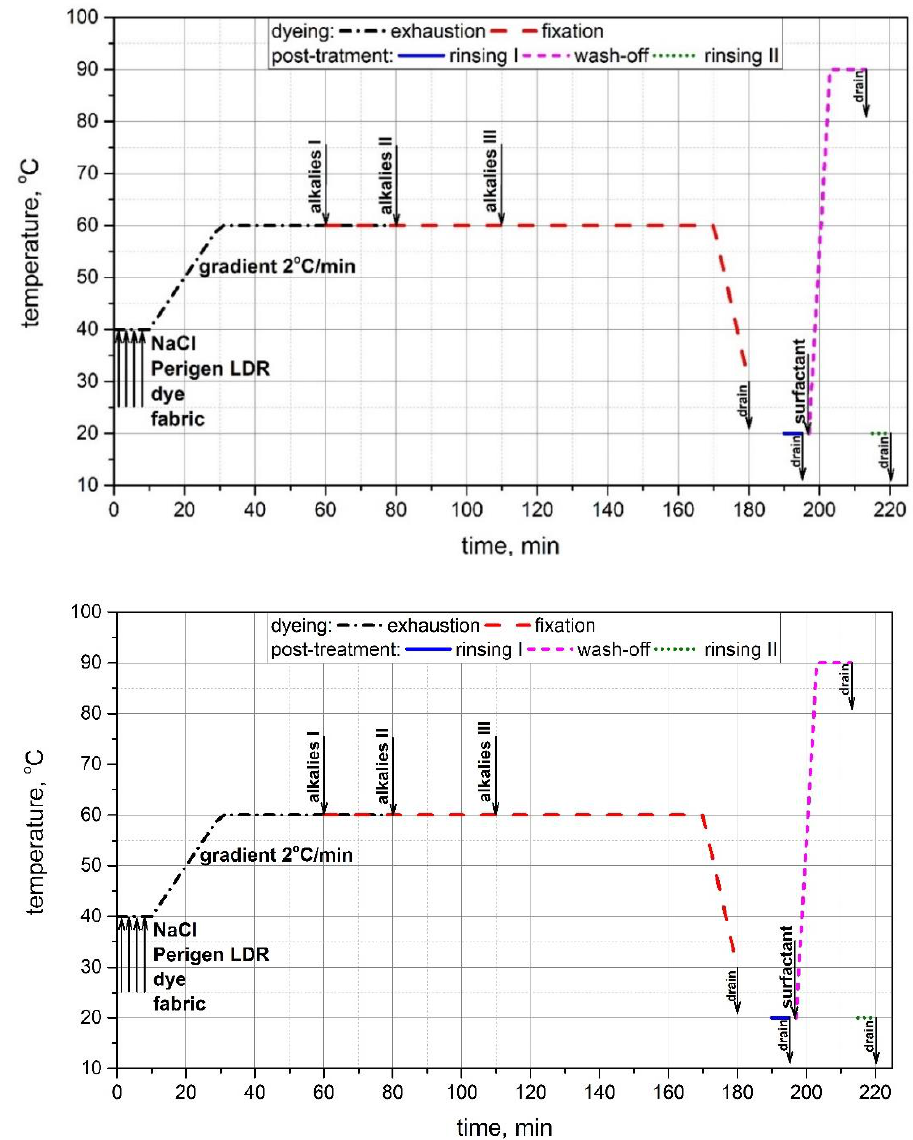
Figure 2. Reactive dyeing of cellulosic fibers according to standard exhaustion-fixation procedure run at a temperature of 60 ° C.